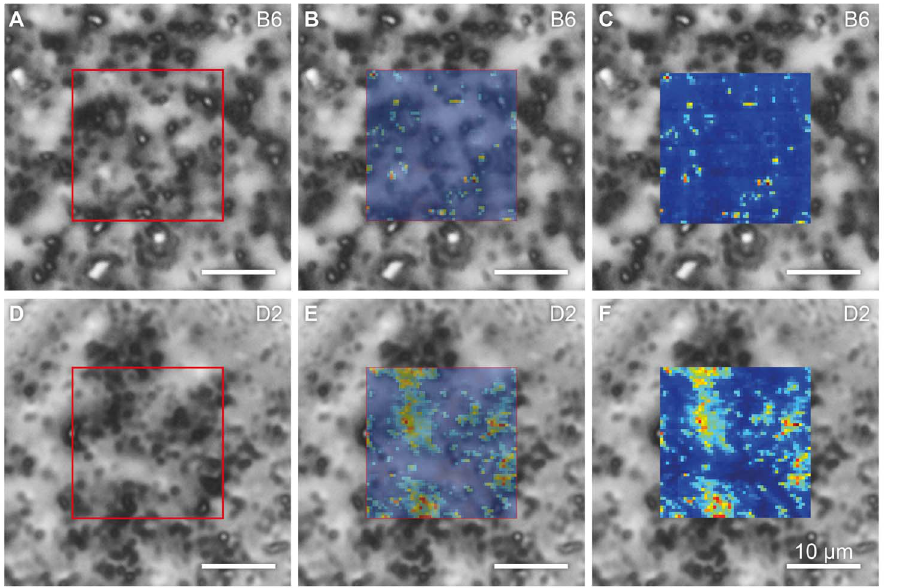
Figure 2. Correlation of maps generated by optical phase-contrast microscopy, cryo microscopy and darkfield cryo-STXM. Melanosomes of the genotypes C57BL/6J (B6) and DBA/2J (D2) are shown in tiles (A–C) and (D–F), respectively. In both cases, the sample is embedded in an amorphous ice matrix. The optical micrographs, recorded at 100 K, are superimposed with a semi-transparent (B and E) and an opaque (C and F) STXM map. Note that despite the fact that melanosome density is comparable in the two samples, the STXM images feature significant differences in signal intensity as well as the spatial distribution of that signal, revealing structural differences between the melanosomes of the two genotypes. The area of the scanned regions is 20.4 6 20.4 m m 2 .